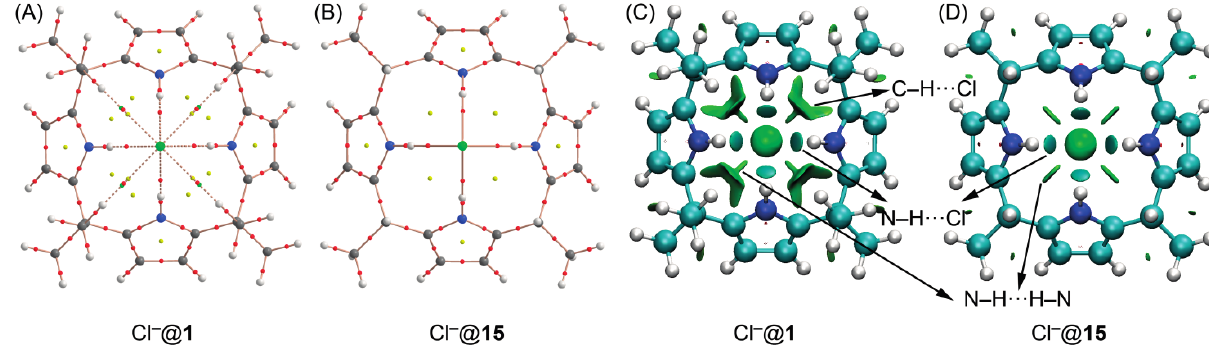
Figure 6. The “atoms-in-molecules” (AIM) analyses of chloride complexes with receptors 1 and 15 ( A , B , respectively). Bond, ring and cage critical points are represented by red, yellow and green spheres, respectively. NCI plots of complexes Cl − @ 1 and Cl − @ 15 ( C , D , respectively ) . Distances are indicated in